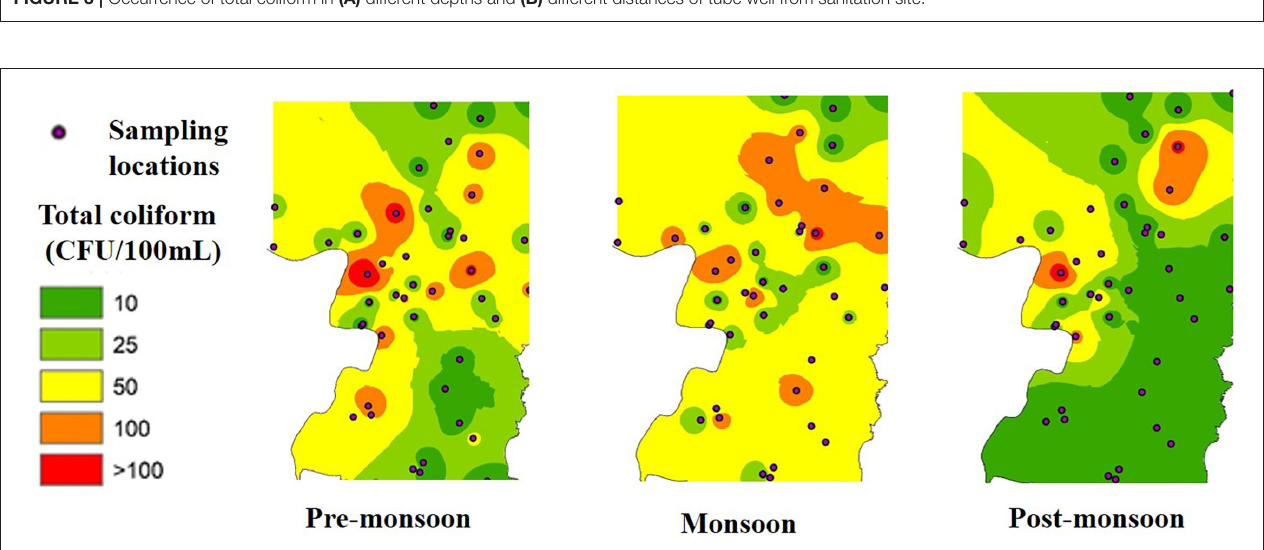
FIGURE 4 | Seasonal and spatial distribution of total coliform across the study area.